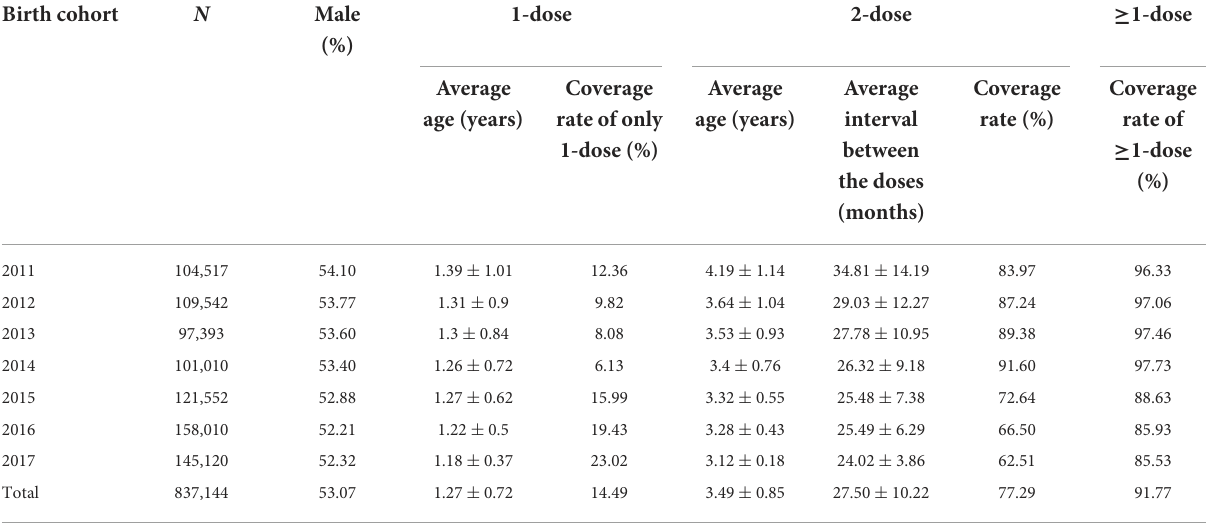
1-dose 2-dose ≥ 1-dose (%) Average Coverage Average Average Coverage Coverage age (years) rate of only age (years) interval rate (%) rate of ≥ 1-dose 1-dose (%) between the doses (months)